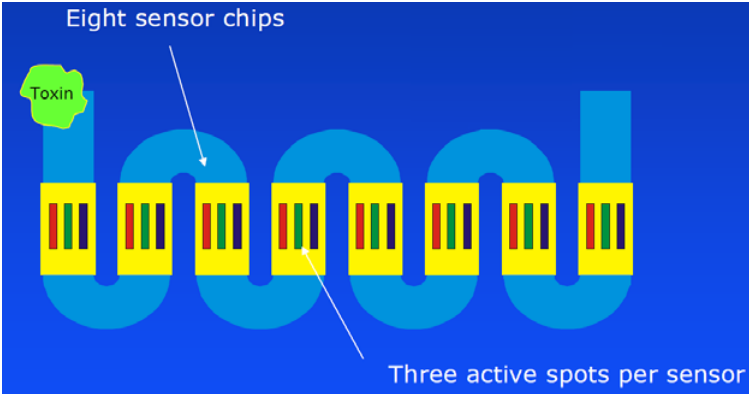
Figure 8. Scheme of the 24-channel SPR sensor based on 3-channel Spreeta chips (modified). Reprinted with kind permission of C. E. Furlong,